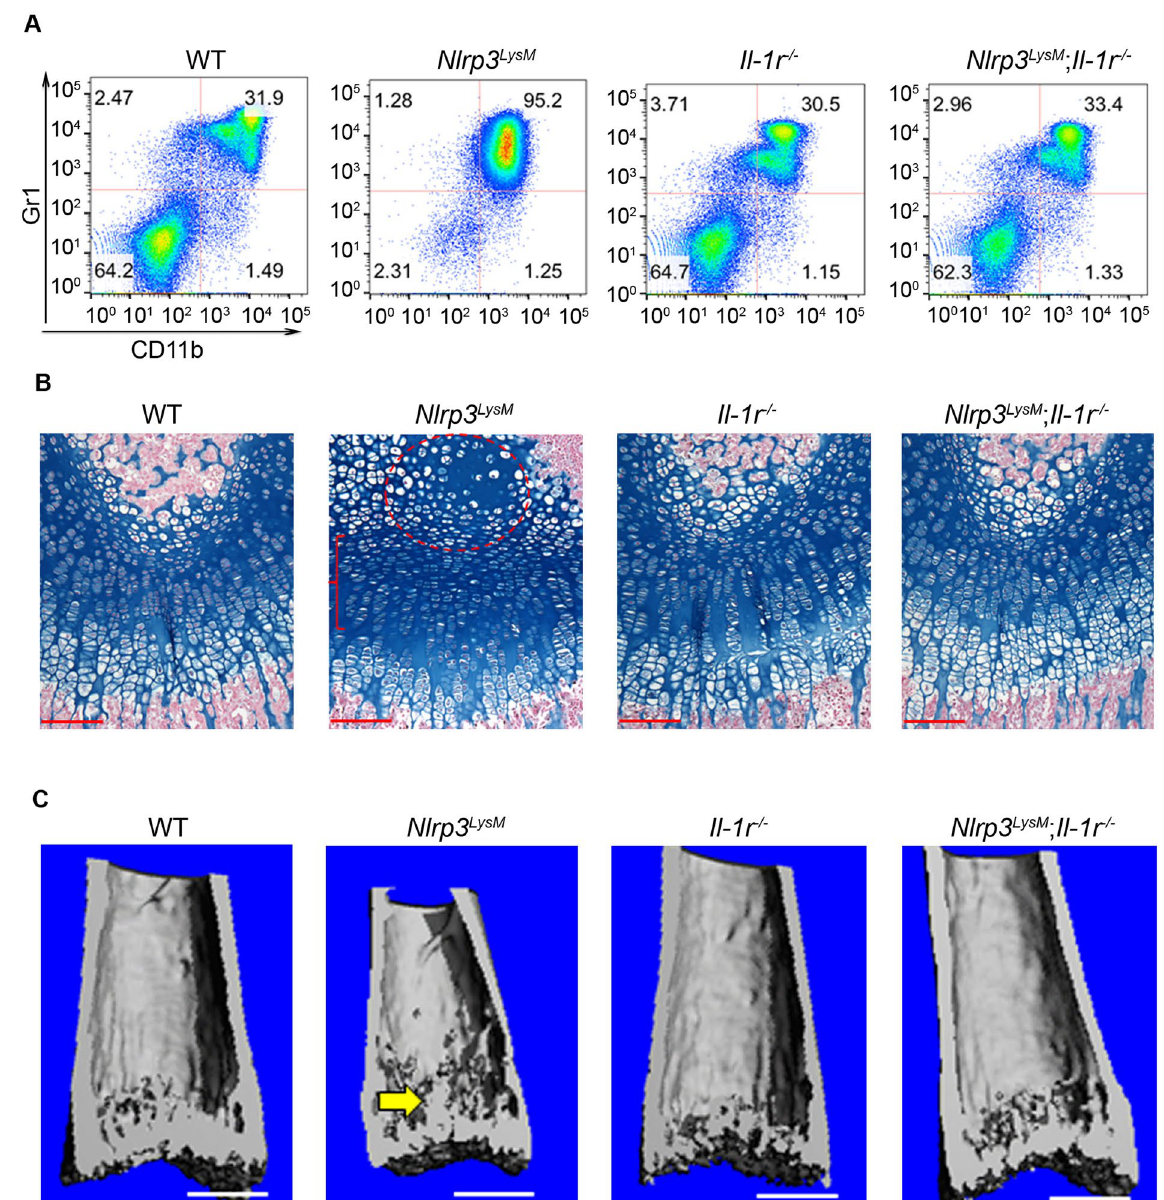
Figure 3. Constitutive activation of the NLRP3 inflammasome in myeloid cells causes inflammation and growth plate defects through IL-1 signaling. All data were obtained from 2-week-old WT, Nlrp3 LysM , Il- 1r − / − or Nlrp3 LysM ; Il-1r − / − male mice (n = 4/genotype). ( A ) Red blood cell-depleted bone marrow cells were stained with isotype control (data not shown) or with antibodies against CD11b and Gr1. Representative flow cytometry dot plots of the CD11b + /Gr1 + myeloid cells from each genotype are shown. ( B ) Safranin O staining. Red circle and bracket indicate areas of hypocellularity within the enlarged center of the epiphysis and growth plate disorganization, respectively. Scale bar, 100 µ m. ( C ) 3D μ CT reconstruction of distal femoral metaphysis. Scale bar, 0.5